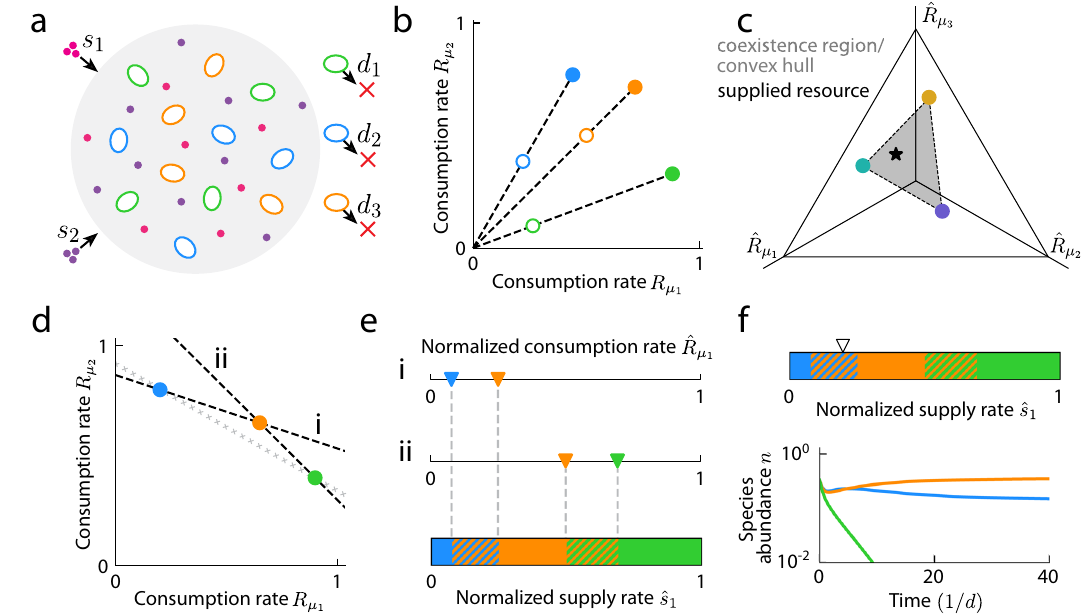
Fig.1|ImplementationofantibioticactivityinaCRmodel.a Schematicofawell- mixed CR model 29 with species-speci fi c death rates d i . Depicted are cells (colored ovals) from three species competing for two resources (small circles) supplied at rates s μ . b The effects of species-speci fi c death rates on coexistence can be determined by reducing the consumption rates R i μ by b i = ð d + d i Þ = d . The trans- formedconsumptionrates(opencircles)havelowerenzymebudgetscomparedto theoriginalconsumptionrates( fi lledcircles). c Whenacommunityofthreespecies competes for three resources, the consumption rates can be visualized on a sim- plex representing the hyperplane containing the consumption niches of the three species in the space of rescaled consumption rates. In the case shown, the convex hull of the species consumption rate vectors (dashed line and shaded gray)